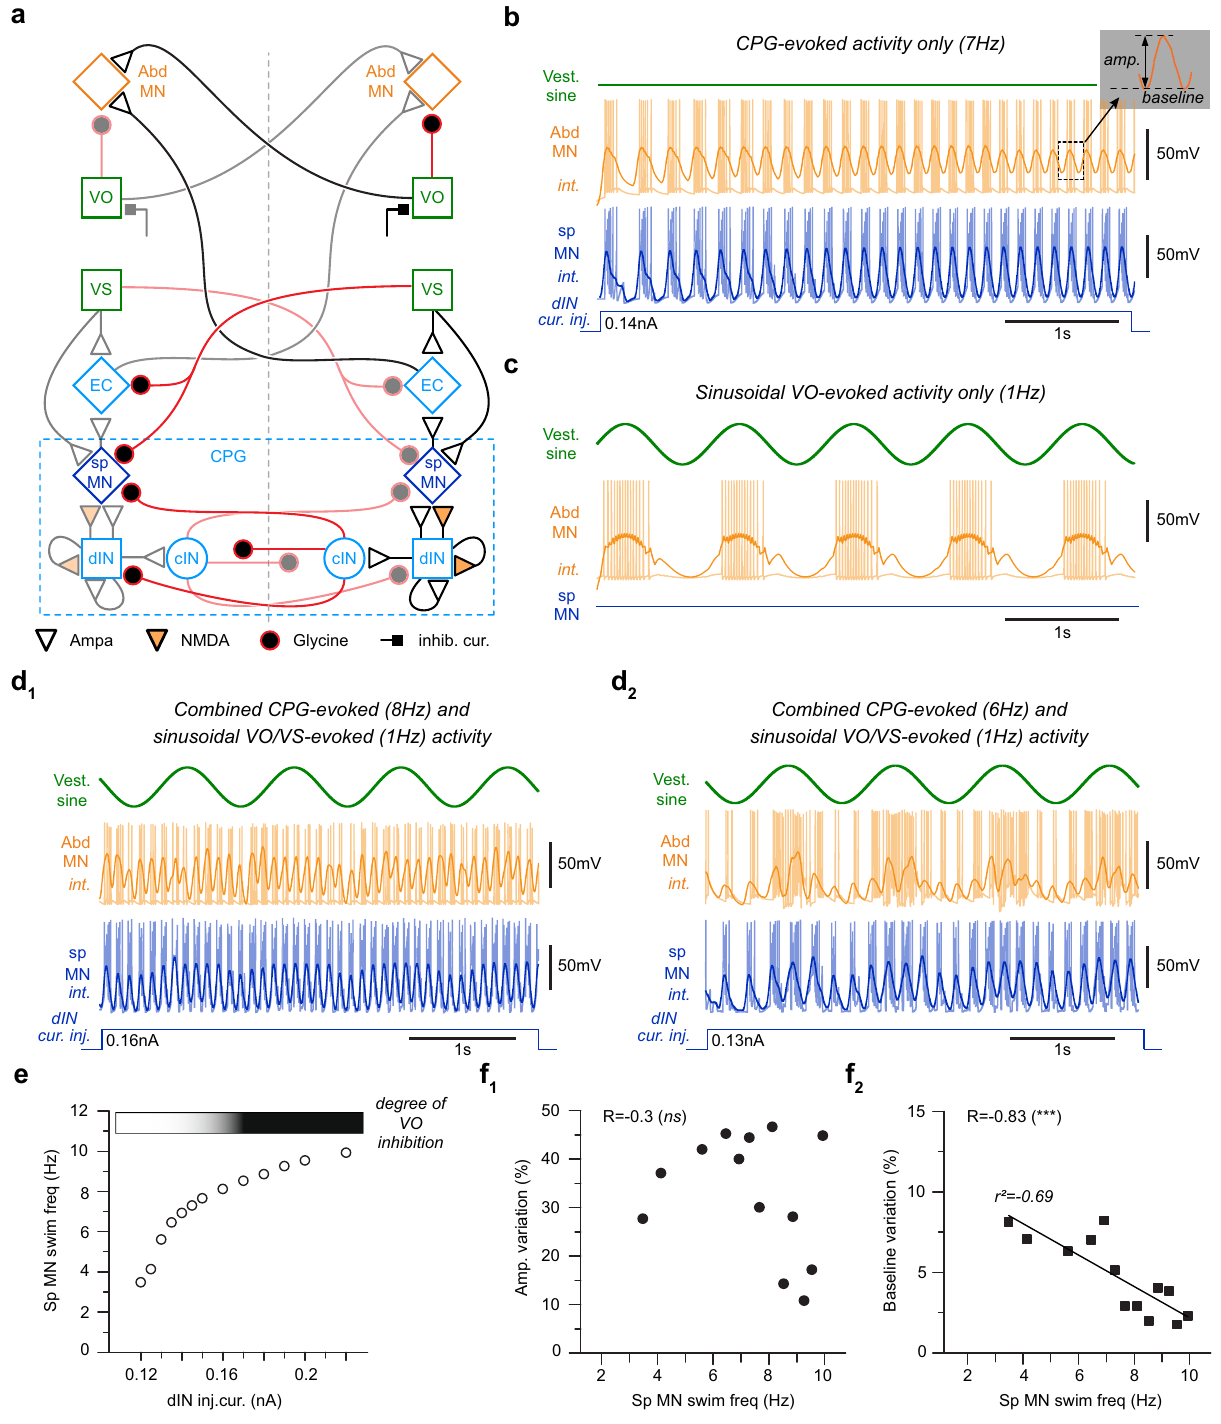
Based on the outcome, the computational modeling was able to reproduce the different ocular motor activity patterns generated during combined head rotation and swim episodes described in semi-intact larval preparations (Fig. 5). These modeling results con fi rmed the differential impact of the swim frequency on the vestibular-driven modulation of the positional eccentricity of the eyes through a VOR frequency-dependent gating mechanism 8 along with the residual effect of the vestibular modulation on the swim-related ocular motion magnitude through vestibulo-spinal